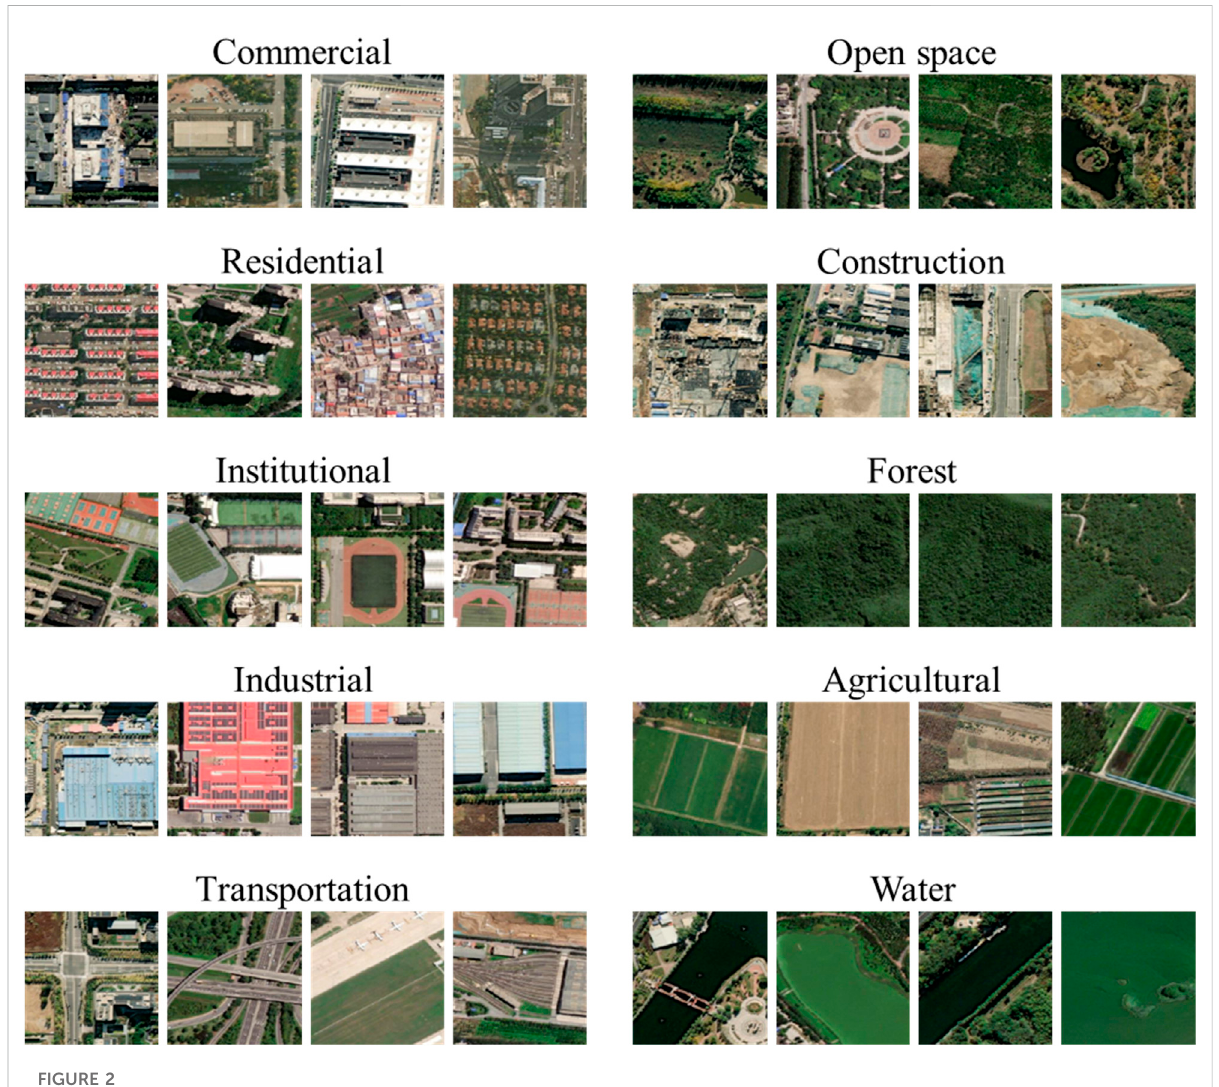
FIGURE 2 Samples of the 10 urban function zone (UFZ)